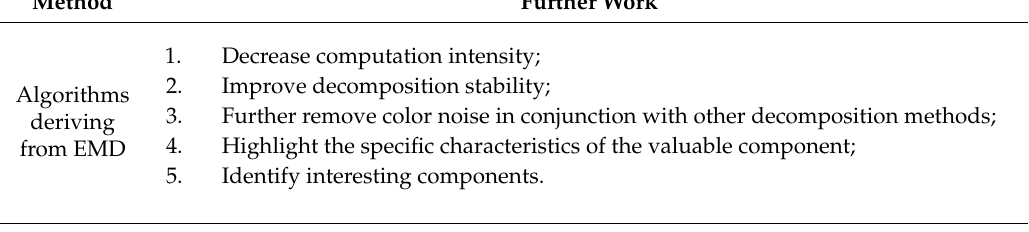
Table 4. Comparison of various time–frequency analysis methods for the rough operation. It should be noticed that algorithms deriving from EMD that are referred in this paper include EEMD, CEEMD, CEEMDAN, and improved CEEMDAN, and the number of sifting iterations is set as 2000, and the stopping criterion threshold is set as 0.05. The conclusion about algorithms deriving from EMD is obtained under these conditions of parameter setting. Because algorithms deriving from EMD, EWT and VMD can work for most cases for the rough operation, we just list the further works for them. Method Further Work